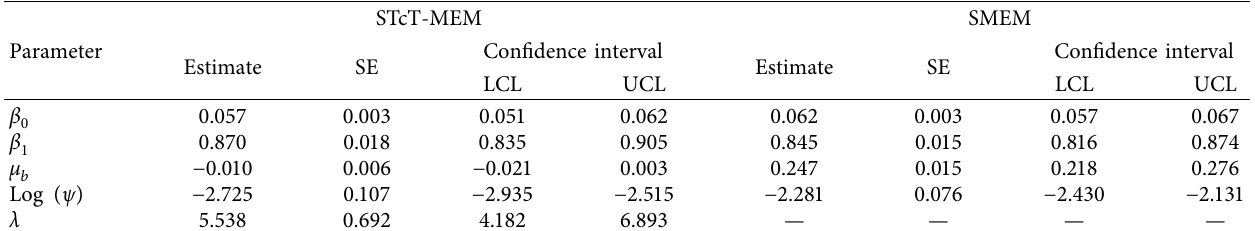
Table 4: ML estimates, their standard errors (SEs), and 95% confdence intervals for parameters of STcT-MEM and SMEM for gold particle data.